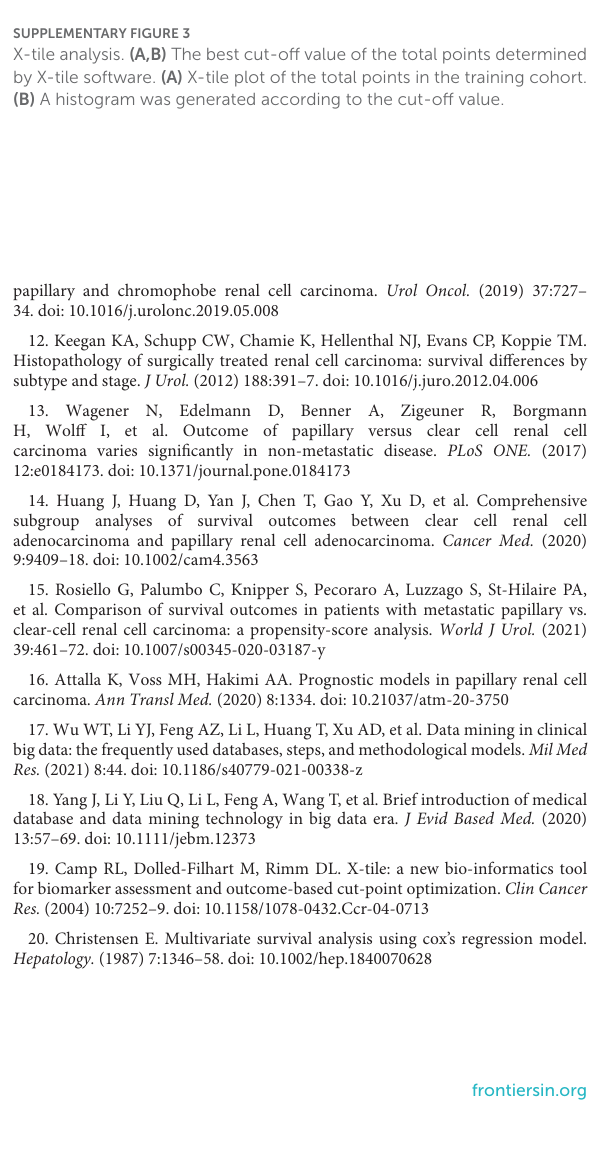
SUPPLEMENTARYFIGURE1 X-tile analysis. (A–D) The best cut-off values of age and tumor size were determined by X-tile software. (A,D) X-tile plots of age and tumor size in the training cohort. (B,E) Histograms and (C,F) Kaplan–Meier plots were generated according to the cut-off values. SUPPLEMENTARYFIGURE2 Forest plot showing the results of multivariate Cox regression analysis in different subgroups. SUPPLEMENTARYFIGURE3 X-tile analysis. (A,B) The best cut-off value of the total points determined by X-tile software. (A) X-tile plot of the total points in the training cohort. (B) A histogram was generated according to the cut-off